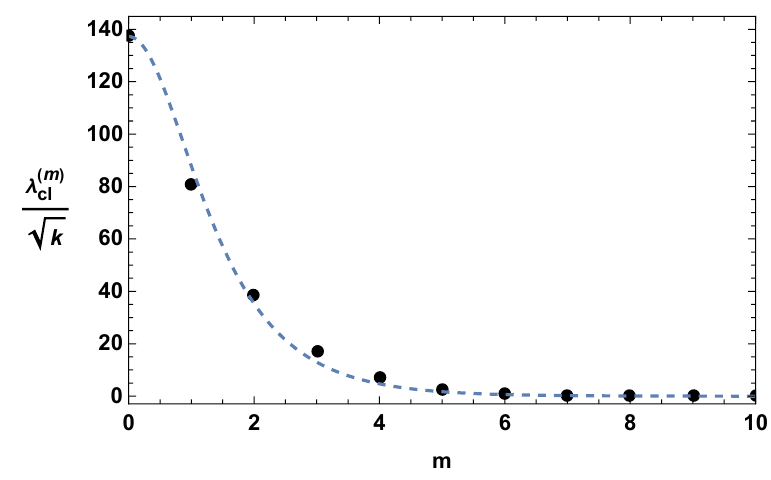
Figure 4 . Black dots are singular values λ ( m ) cut at x o = 0 . The dashed line is a one-parameter fit of the data to the analytic form of (4.36): λ ( m ) = 0 . 82 λ o sech cl